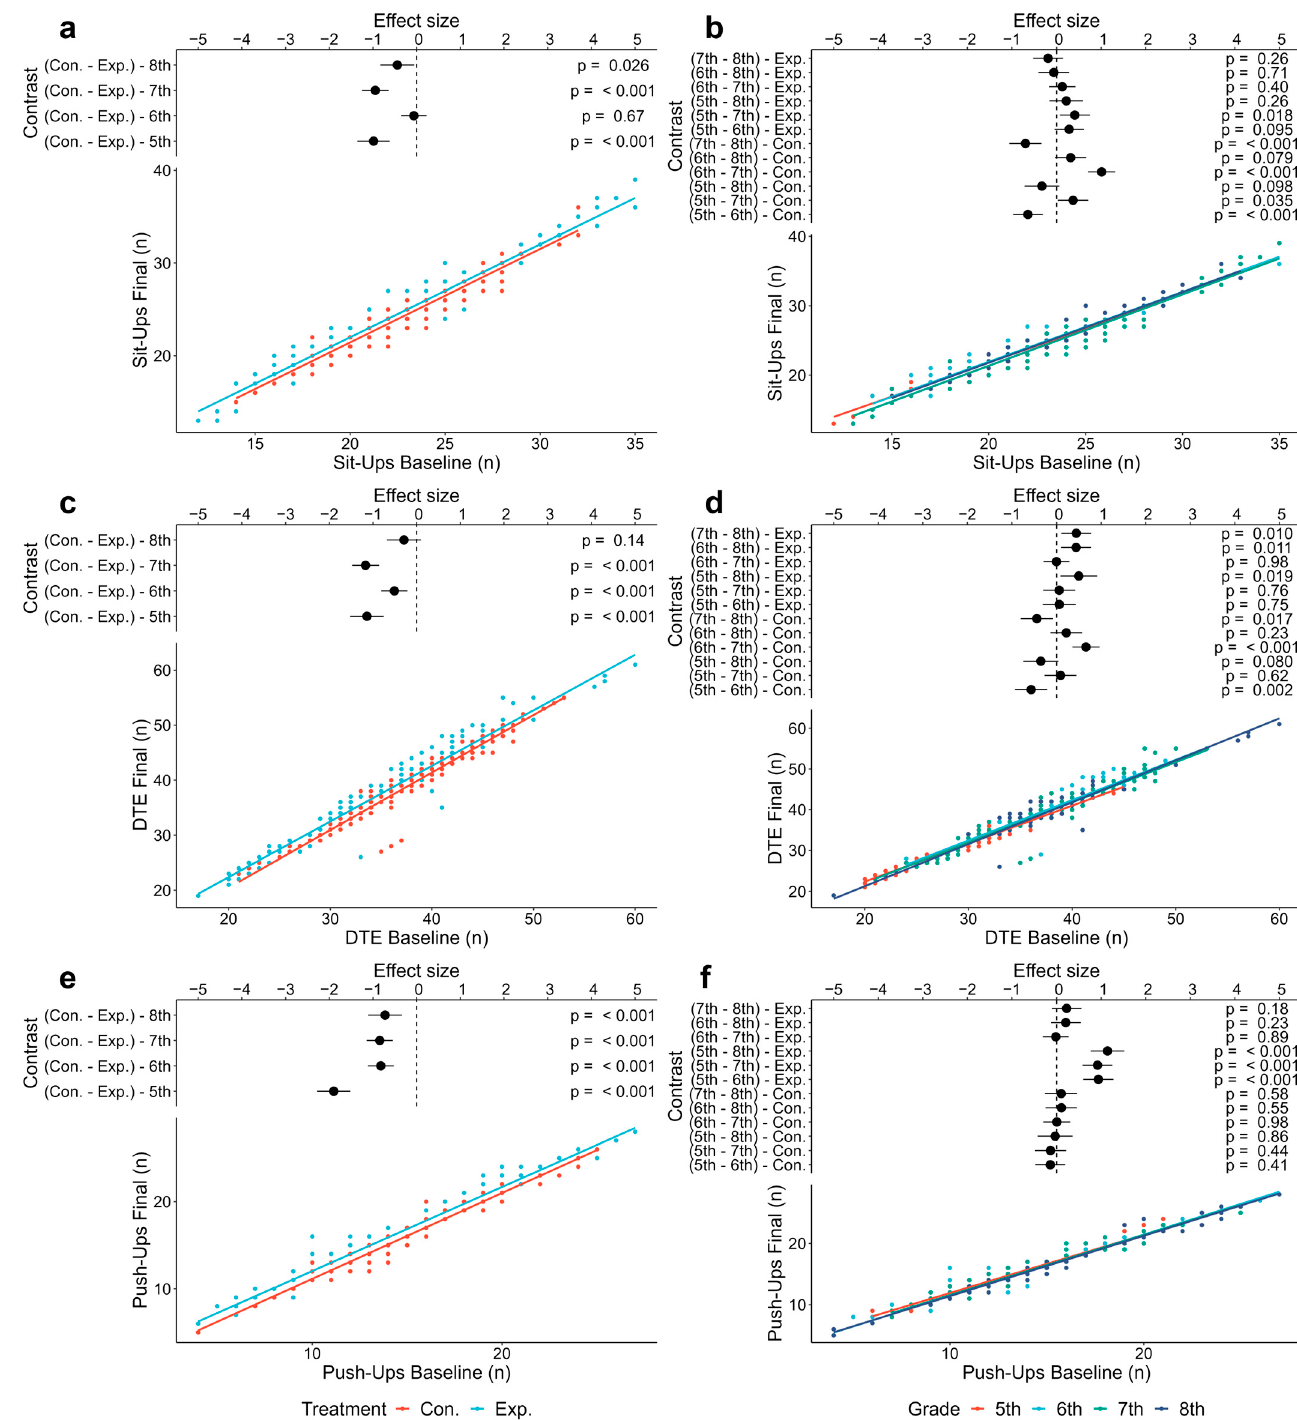
Figure 4. The two-way ANCOVA interaction plot shows the treatment effect (experimental vs. control) on the outcome of the response variables, adjusted for the baseline measurement. ( a , c , e ) represent the interaction effects (grade presented) for sit-ups, DTE, and push-ups, respectively. ( b , d , f ) represent the interaction effects (treatment presented) for sit-ups, DTE, and push-ups, respectively. The regression lines with data points display the treatment–grade interaction, while the effect size and p -value represent the simple main effects.